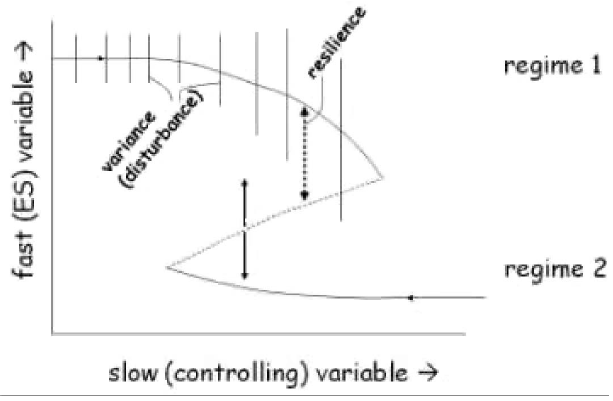
Fig. 3. The variance around the stable state of a fast variable (good/service) rises as the slow variable approaches a threshold level, due to an interaction of exogenous variance and internal ecosystem processes. The fluctuations become larger at the same time resilience is becoming smaller. Such “shocks” to the fast variable can push it across the threshold and cause the system to shift into the alternative regime (stability